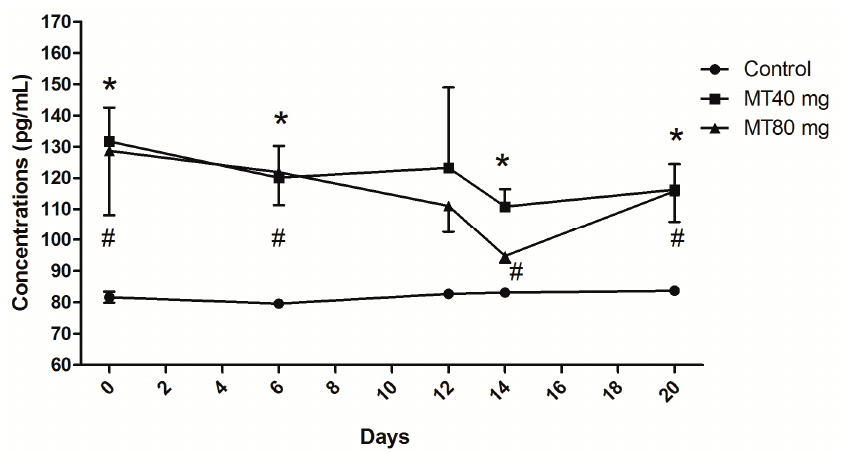
MT40 mg group and MT80 mg group, respectively. “ * ” or “#” mean p <